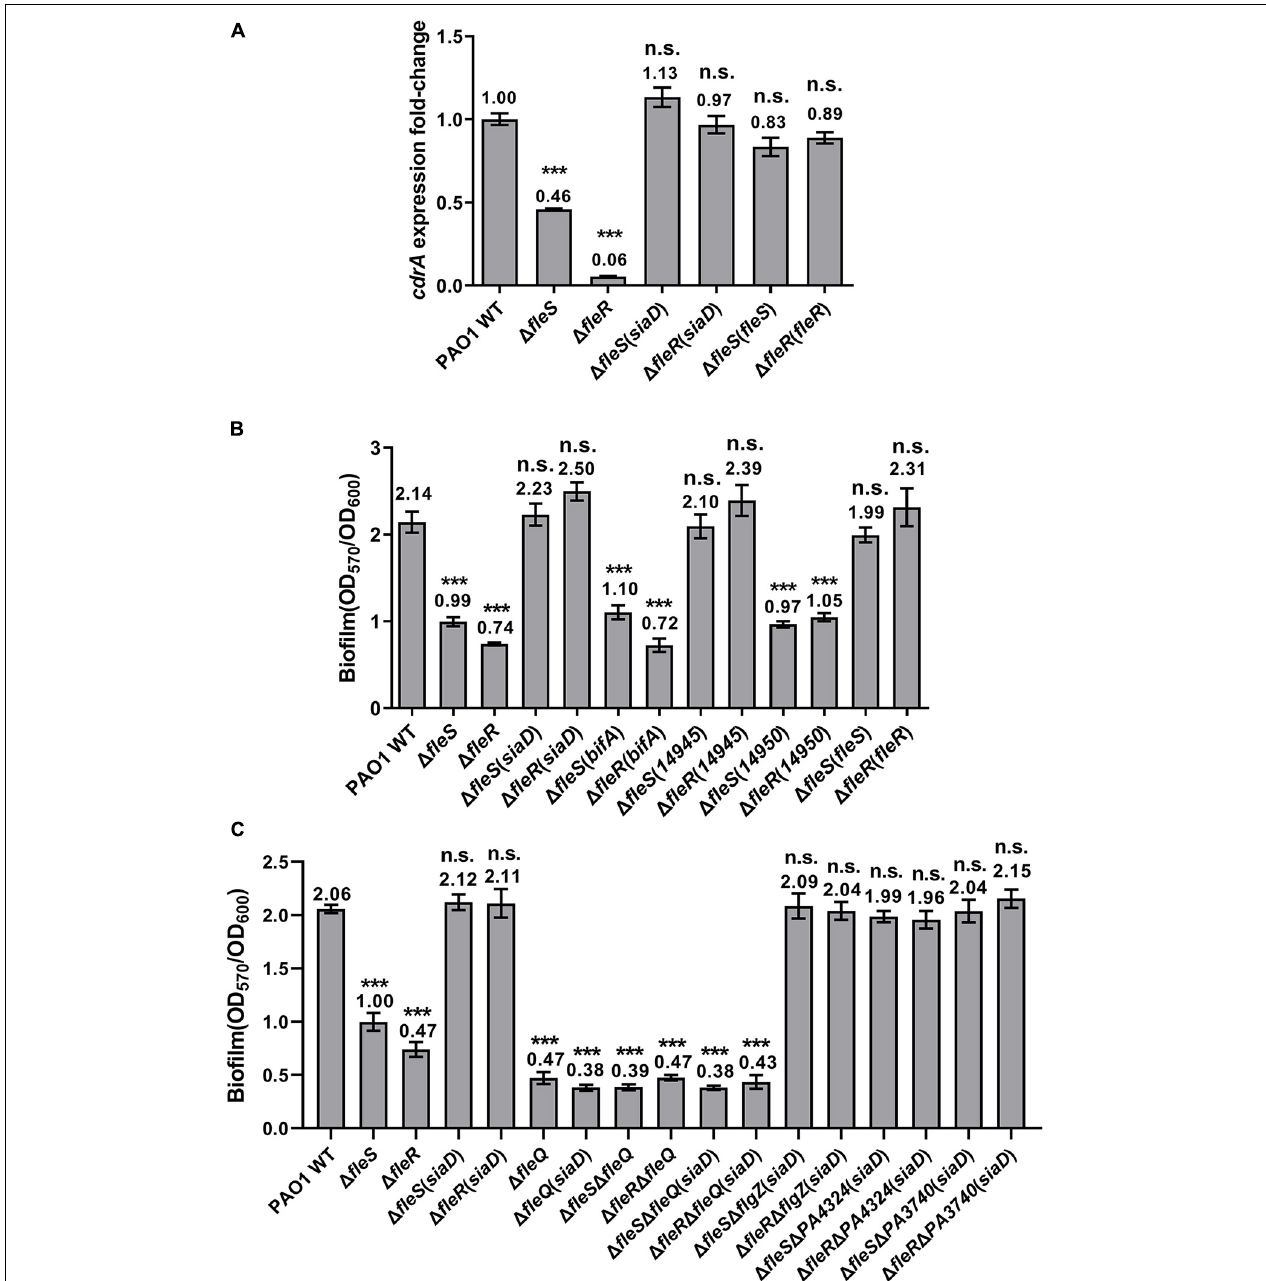
FIGURE 6 | The regulation of FleS/FleR on biofilm formation is mediated by c-di-GMP. (A) Expression levels of cdrA were examined in the PAO1 wild type (WT), (cid:49) fleS and (cid:49) fleR mutants as well as the mutants with overexpression of a diguanylate cyclase gene siaD . The result is shown as relative cdrA expression compared to its wild-type level in PAO1. (B) Biofilm formation of the PAO1 wild type, (cid:49) fleS and (cid:49) fleR mutants as well as the mutants with overexpression of SiaD from PAO1 and W909_14945(14945) from D. zeae EC1. PDEs BifA from PAO1 and W909_14950(14950) from D. zeae EC1 serve as negative controls. (C) Examination of the effect of FleQ and other PilZ domain-containing proteins on biofilm formation in the presence of overexpressed SiaD. *** P < 0.001, n.s., no significance (Student’s t